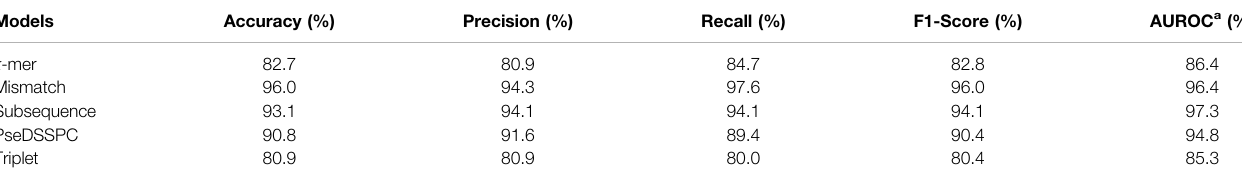
TABLE 1 | Performance of the fi ve strong classi fi ers.